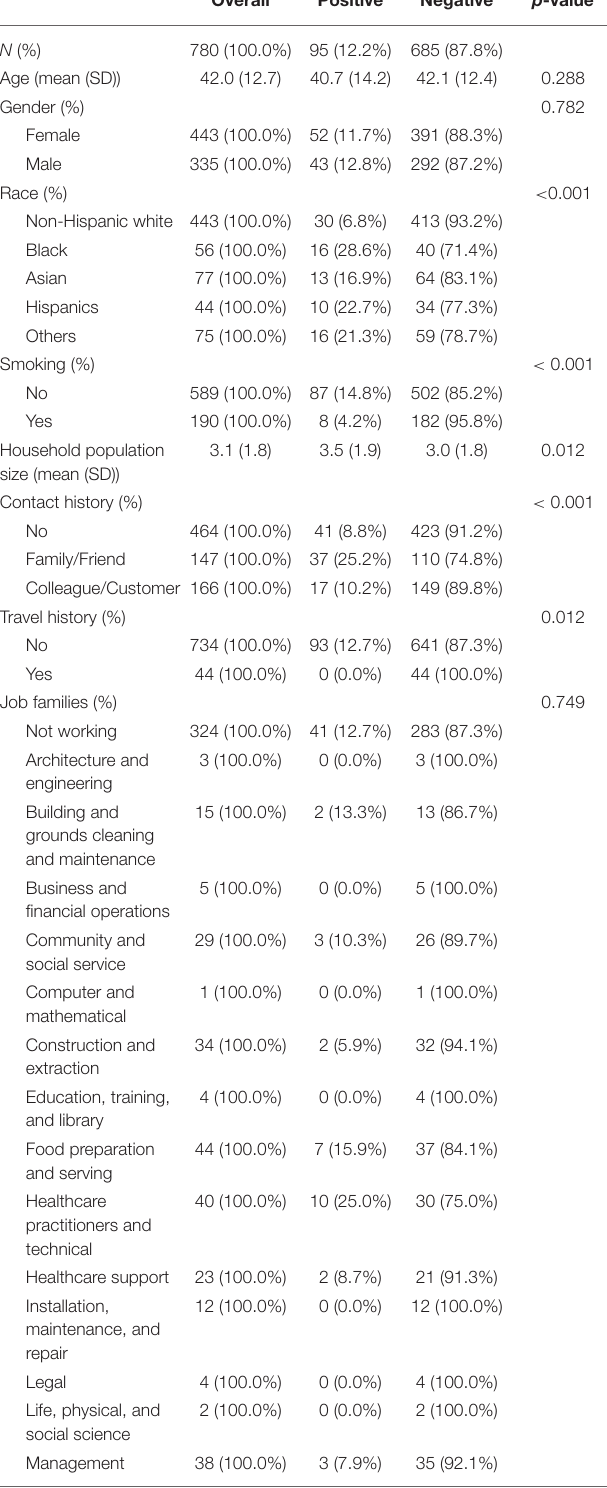
TABLE 1 | Comparison of baseline sociodemographic, job category, and work condition in study population between March 18,2020 and June 19, 2020, stratified by SARS-CoV-2 RT-PCR assay results a